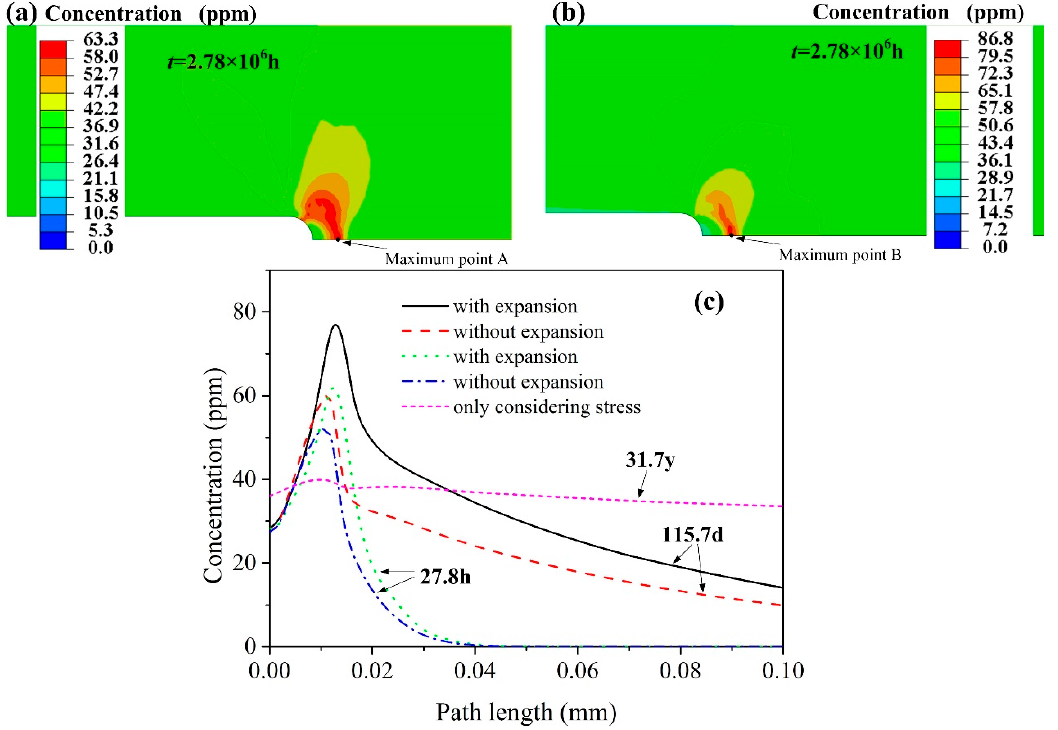
Figure 4. Hydrogen concentration results. ( a ) Hydrogen distribution without considering the volume expansion, ( b ) hydrogen distribution with considering the volume expansion and ( c ) comparison of the concentration along the